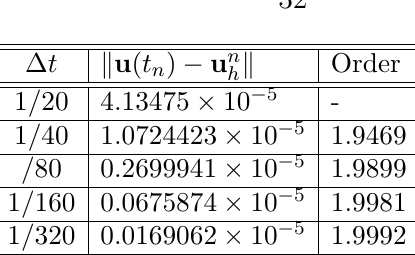
of the partitioned t . 0 N = 1 , with h = 1